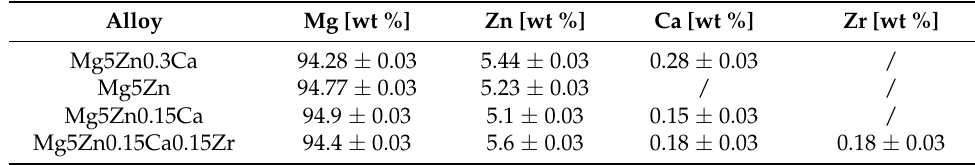
Table 1. Chemical composition of the investigated